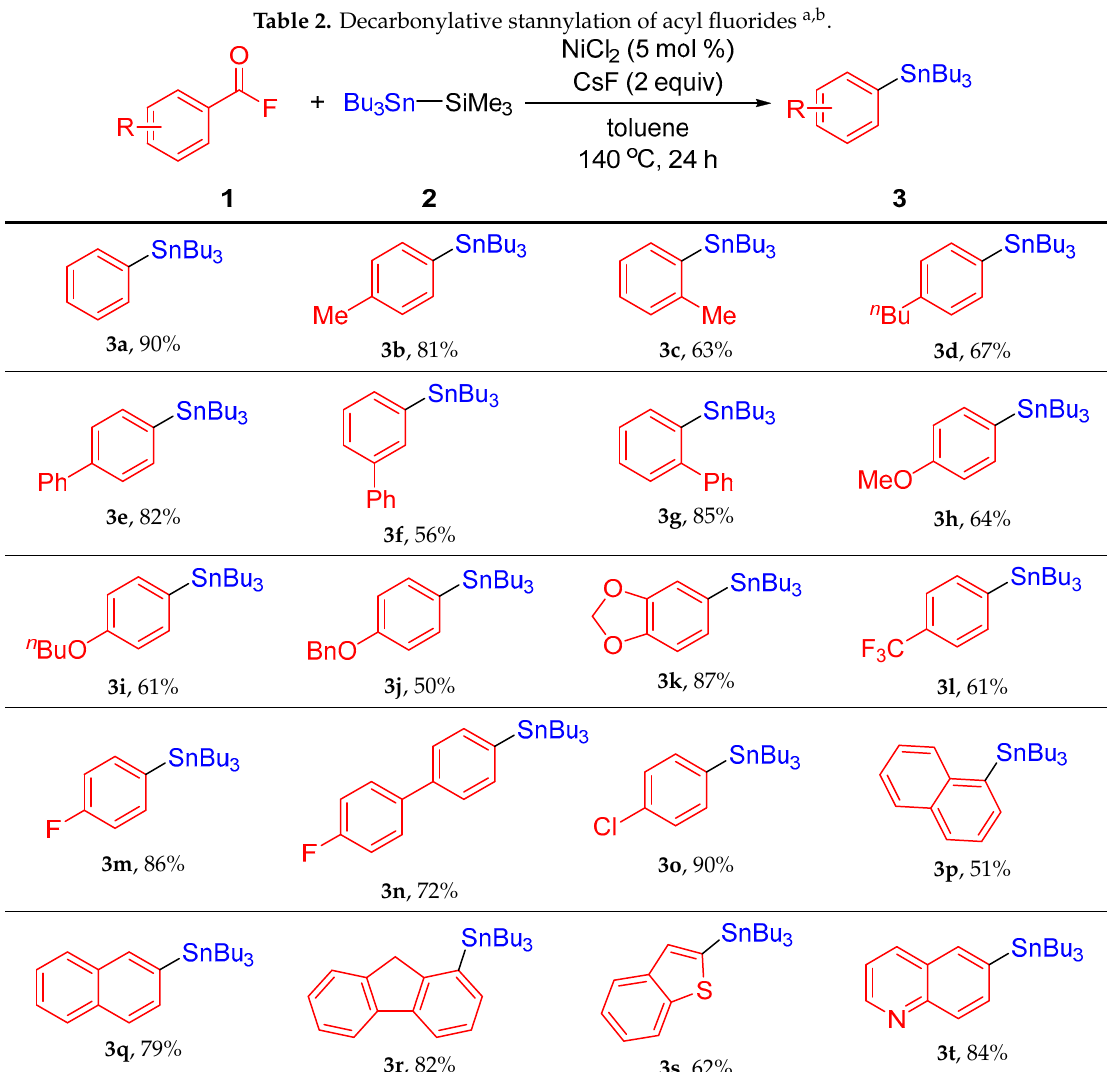
Table 2. Decarbonylative stannylation of acyl fluorides a,b .